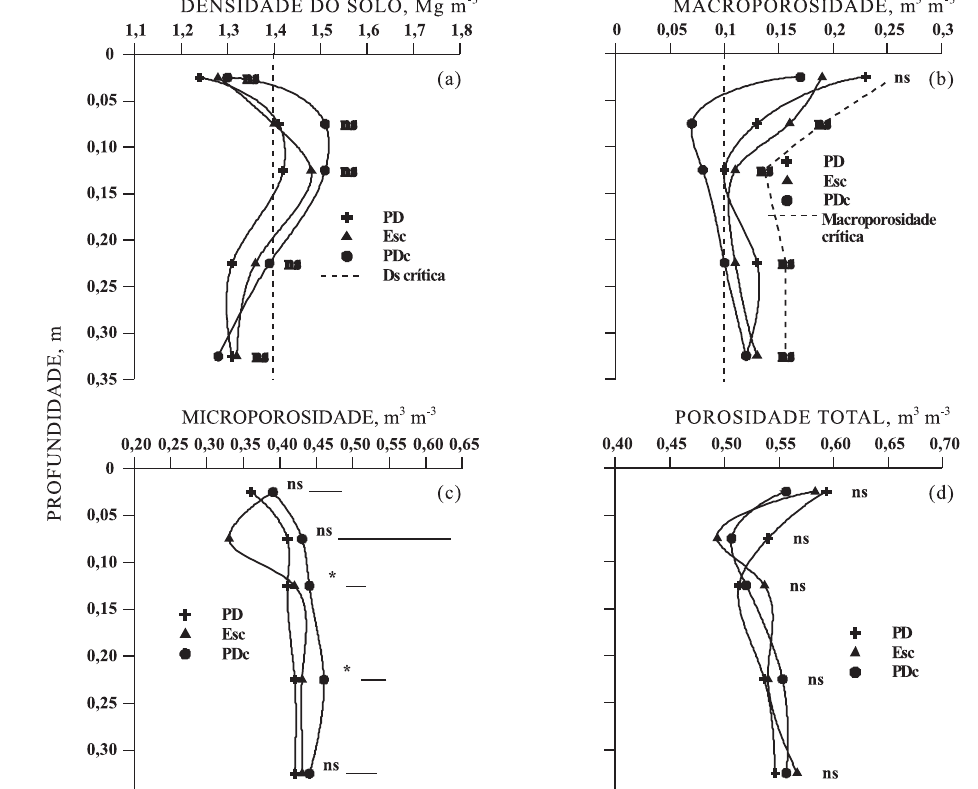
Figura 1. Valores da densidade do solo (a), macroporosidade (b), microporosidade (c) e porosidade total (d), em Latossolo sob plantio direto contínuo (PD), plantio direto com compactação adicional (PDc) e com escarificação (Esc), em 24/2/2003 (40 DAS). (ns: não-significativo; *: significativo pelo DMS a 5